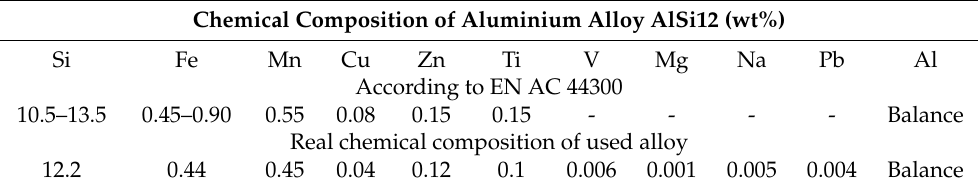
Table 2. Chemical composition of the AlSi12 aluminium alloy used.